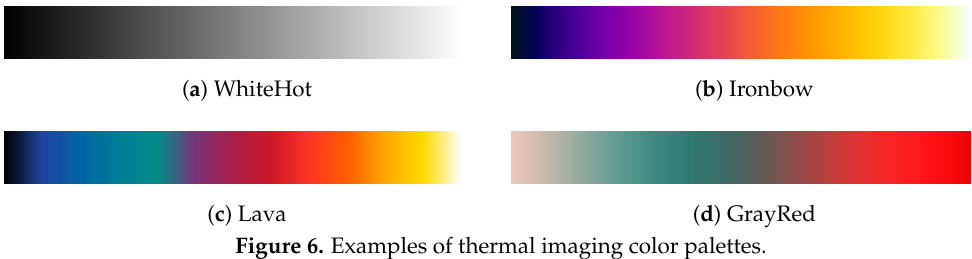
Figure 6. Examples of thermal imaging color palettes.